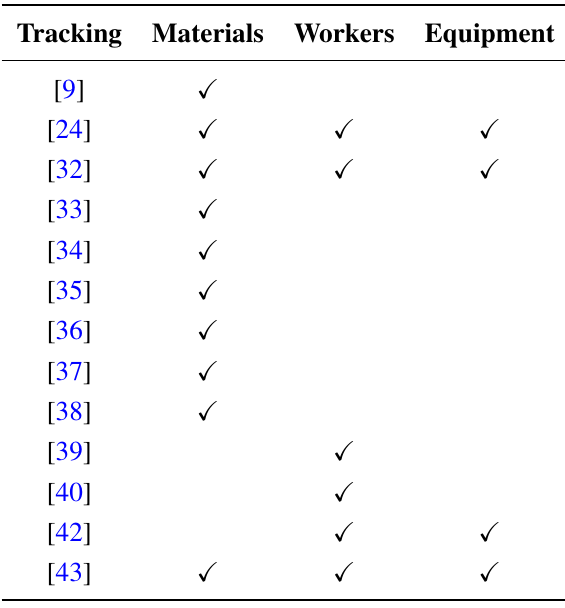
Table 5. Use of RFID tags for locating